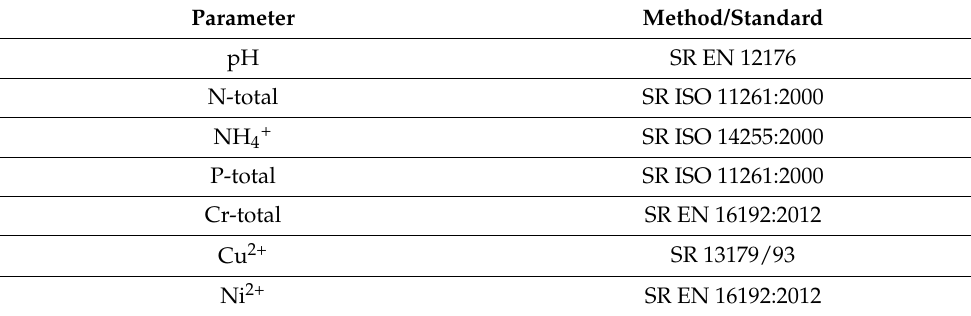
Table 1. Methods of sewage sludge and agricultural soils analysis [38–45].